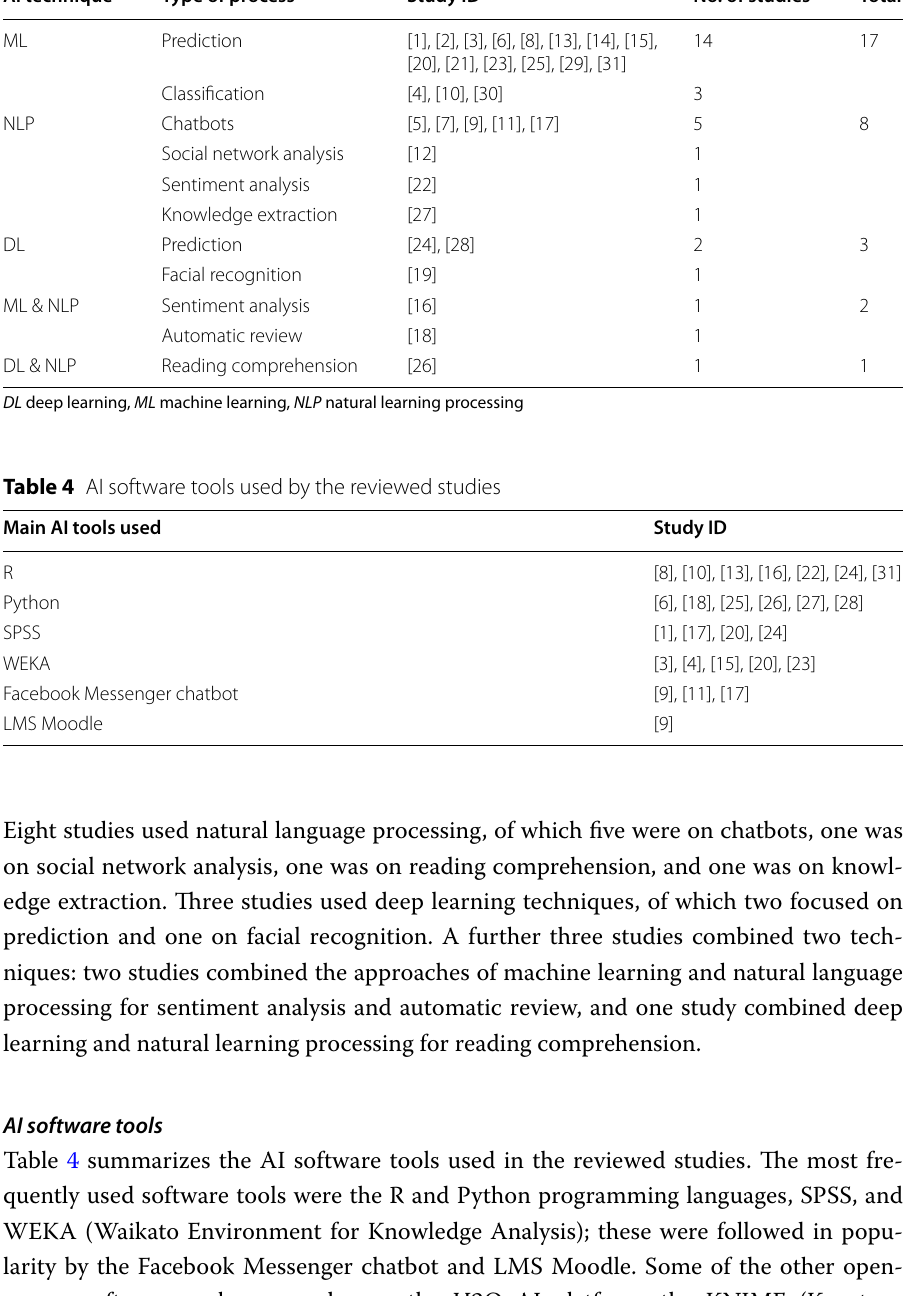
Table 3 AI techniques and the type of process used by the reviewed studies